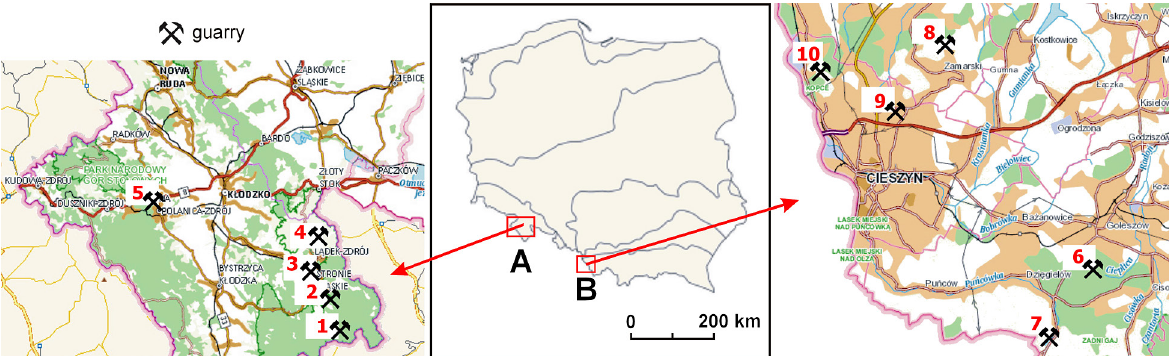
Fig. 1. Location of the selected quarries in the Kłodzko Region (A) and Cieszyn Foothills